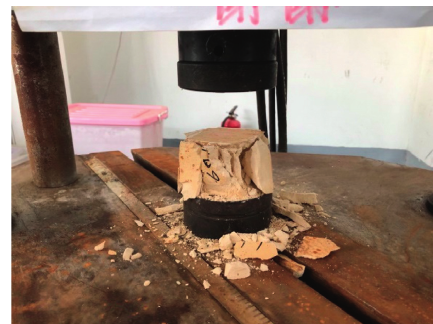
Figure 5: Compressive strength tests of the gypsum specimen.